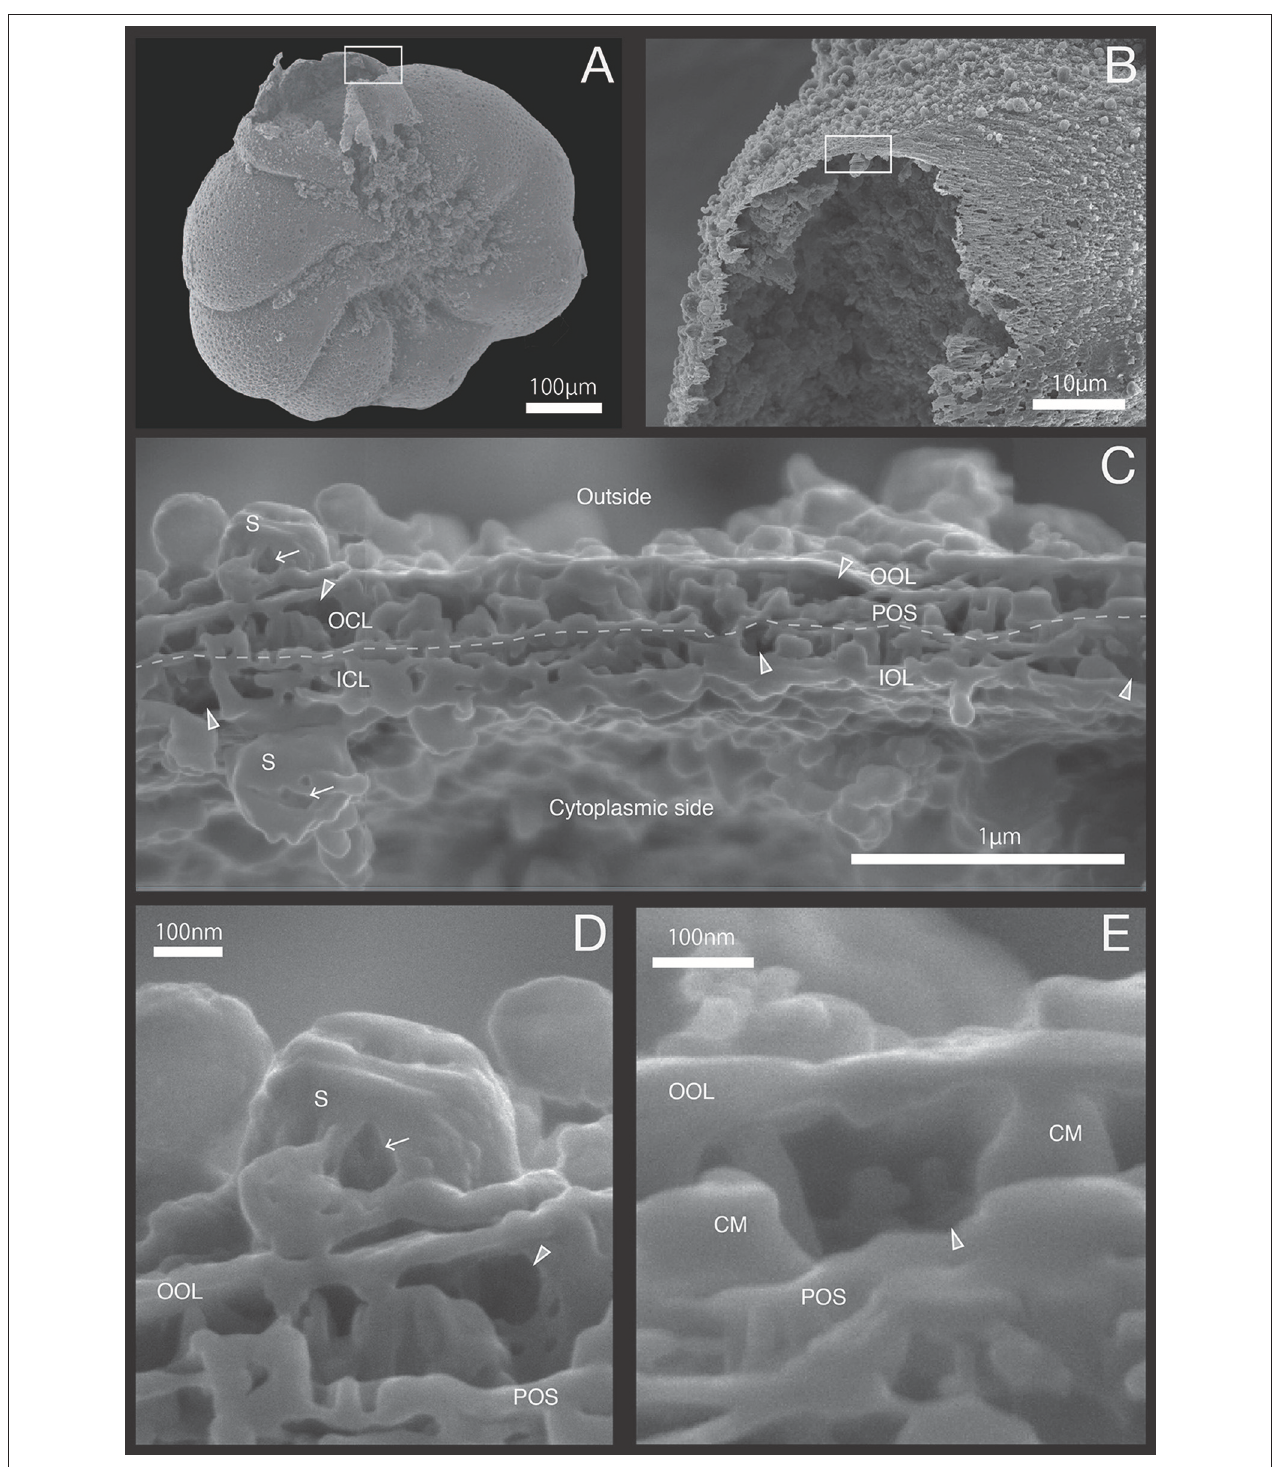
FIGURE 2 | SEM images showing the microstructure of the SOC in specimen #1 processed by FIB on the newly calcified chamber wall. (A) Overview. (B) The newly calcified chamber (white rectangle in (A) . The field of FIB processing is indicated by the white rectangle. (C) Composite SEM cross section of SOC of specimen #1. Upper side is the outside whereas the lower side is the cytoplasm side. The white dotted line in the calcareous layer indicates the boundary between outer side and cytoplasmic side of calcareous layer. (D) Magnified image of the empty inside of spherical structures on outer organic layer. (E) Higher magnification showing the void. OOL, outer organic layer; OCL, outer calcareous layer; POS, primary organic sheet; ICL, inner calcareous layer; IOL, inner organic layer; S, spherical structures; CM, calcareous materials; gray triangles, void; white arrows, cavities.